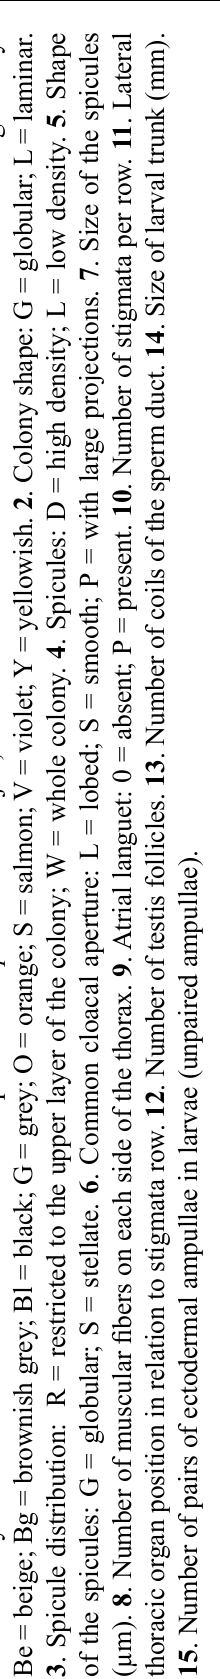
o c ac i ho r t